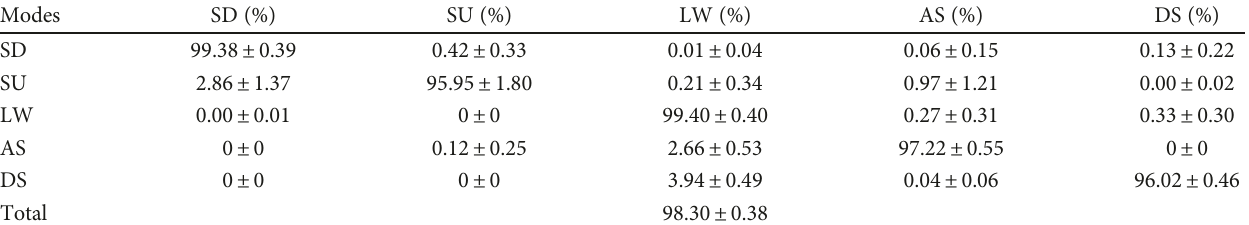
Table 2: Experimental results of the proposed DLMIM.